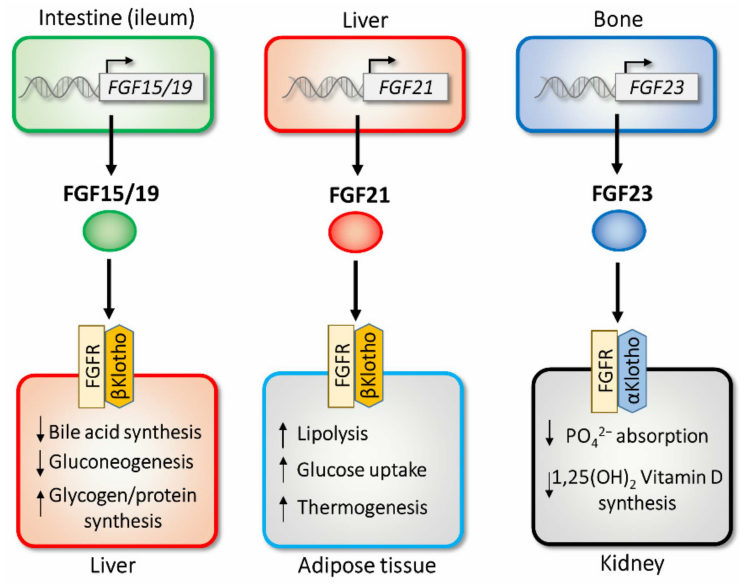
Figure 1. Endocrine functions of FGF15/19, FGF21, and FGF23. FGF15/19 , FGF21 , and FGF23 are expressed in intestine, liver, and bone, respectively. Secreted FGFs selectively act on the target tissues through FGF receptor (FGFR)/Klotho receptor